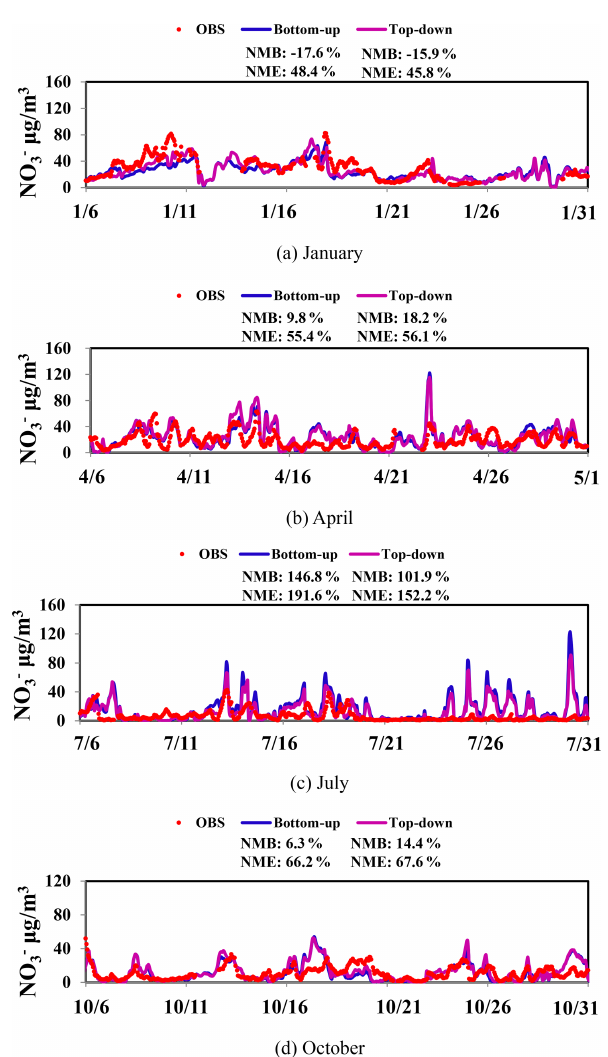
Figure 9. The observed and simulated hourly NO − with the bottom-up and top-down NO x emission estimates for Jan- uary, April, July, and October 2016 at JSPAES.